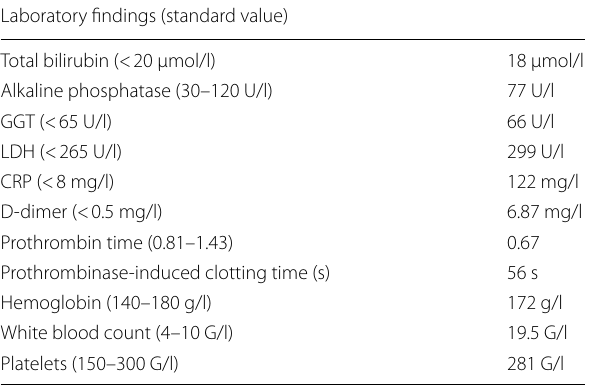
Table 1 Blood findings on admission